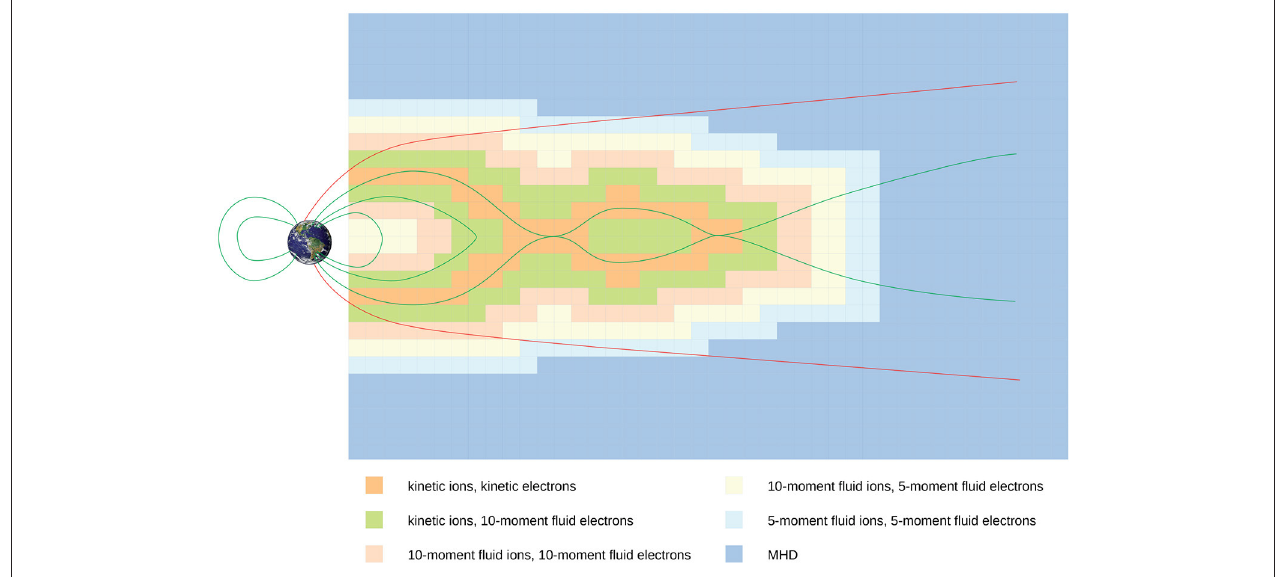
FIGURE 1 | Oversimplified sketch of a multiphysics approach for tail